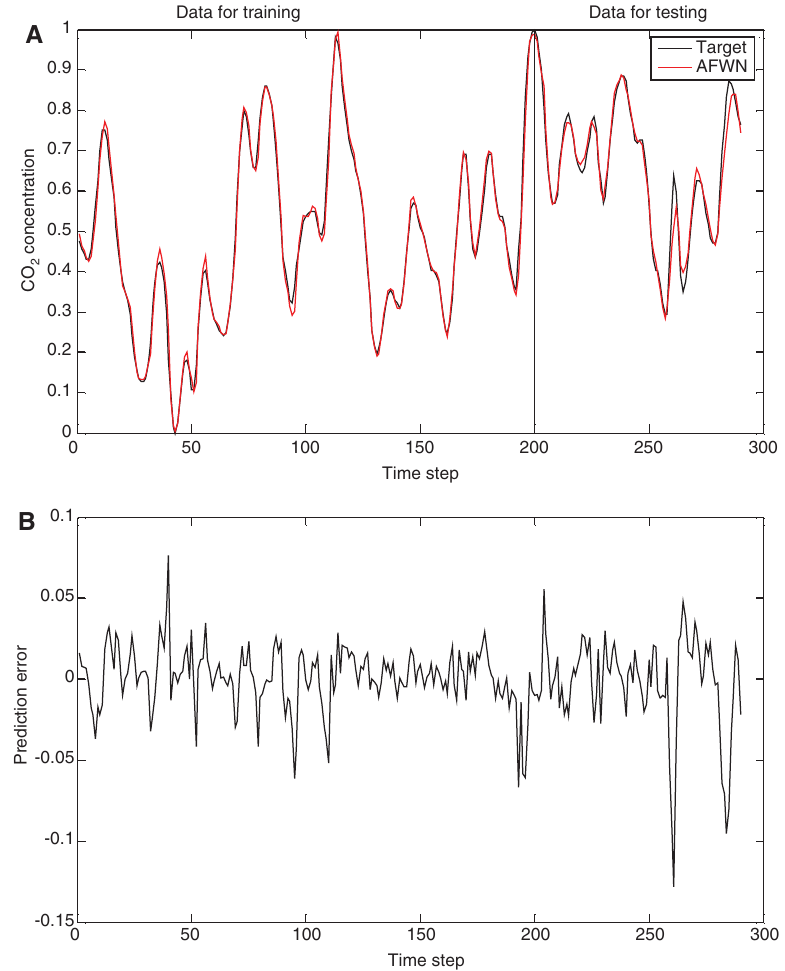
Figure 2. AFWNN Model Results for Gas Furnace Time Series. (A) Actual and prediction values. (B) Prediction